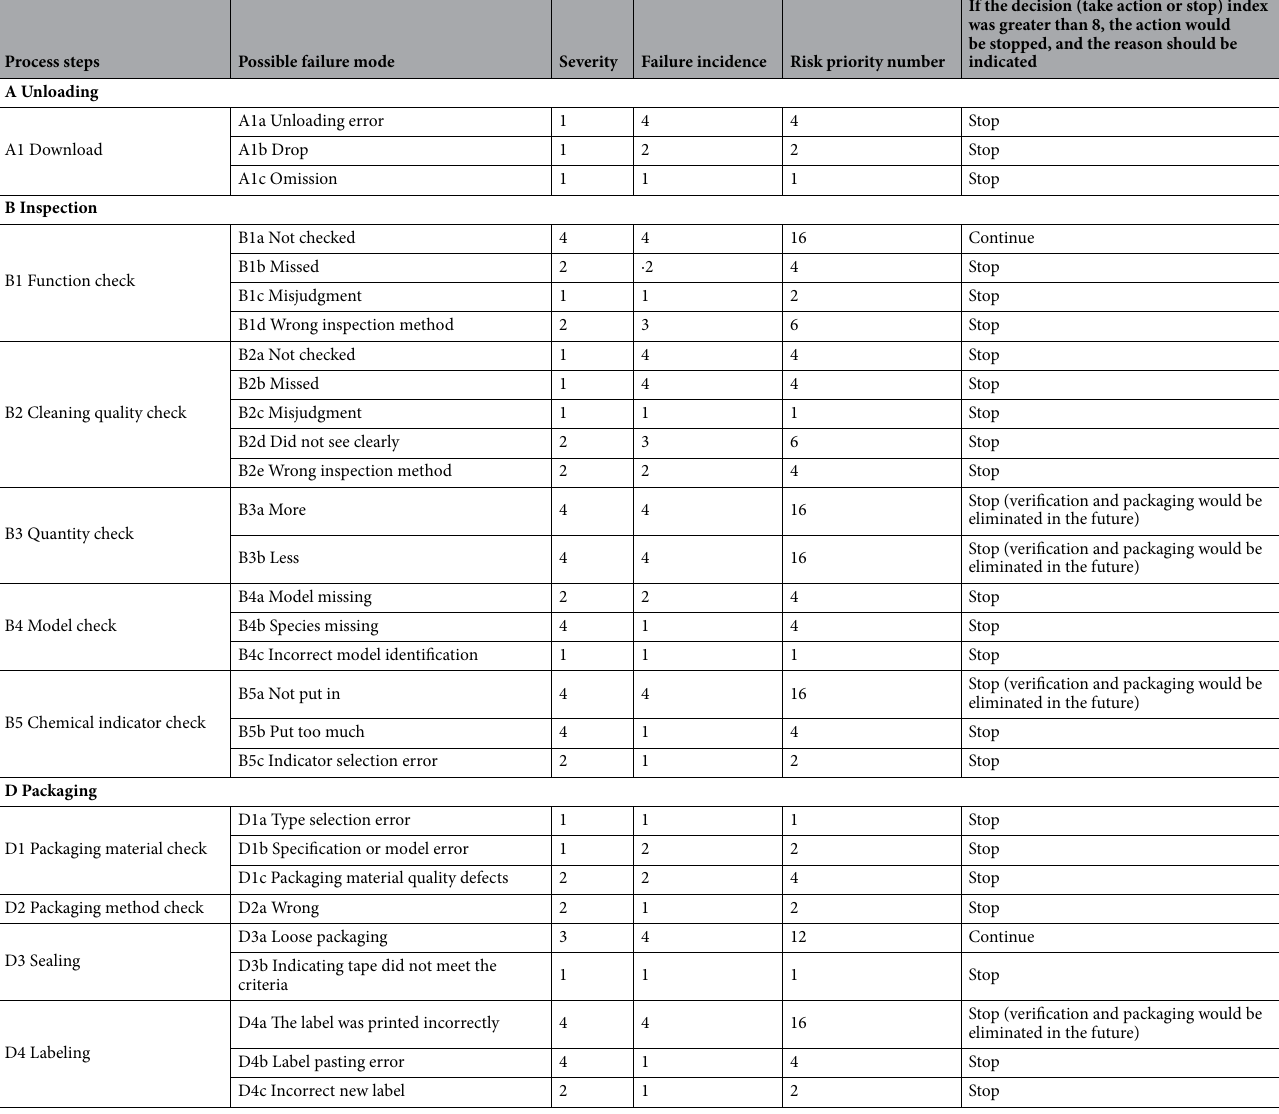
Table 1. Screening of high-risk links in failure modes of packaging